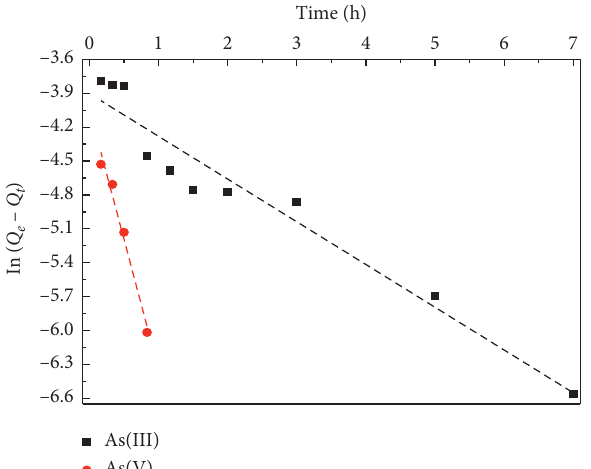
Figure 8: The pseudo-first-order kinetic plots for As(III) and As(V) removal at pH � 8, adsorbent dosage 0.5g, and initial arsenic concentration 1.3 mg/L.